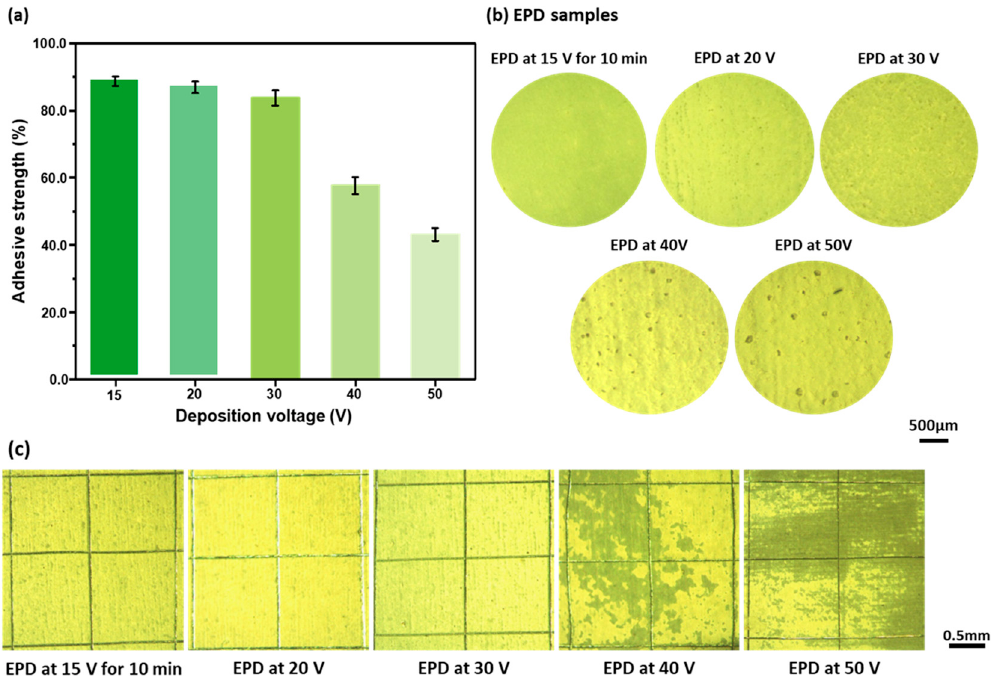
Figure 14. Adhesive strength of the post-treated coatings deposited at different voltages varying from 15 to 50 V ( a ), corresponding microscopic images of the coatings after the adhesive strength test ( b ) and images of the coatings after the cross-hatching tests ( c ).